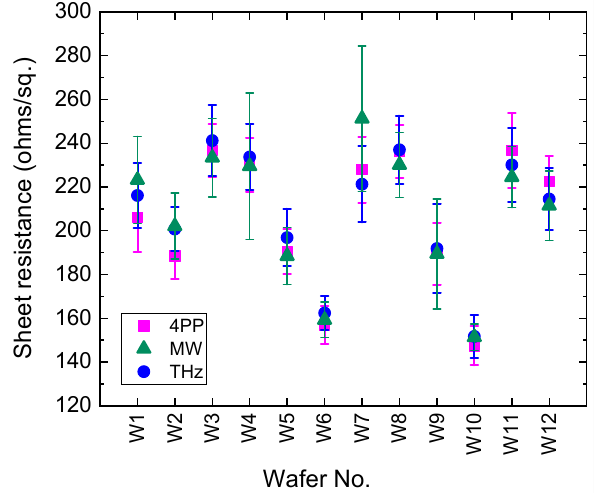
Figure 10. Mean sheet resistance of 12 wafers measured using the four-point probe (4pp), microwave resonator and THz time-domain spectroscopy. Each wafer was measured at multiple locations; the data points are the mean and standard deviation of all measured values.